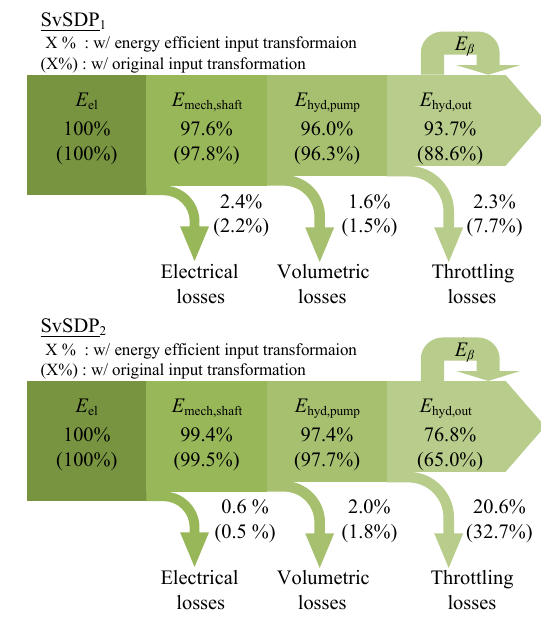
Figure 18: Sankey diagram showing the energy distri- bution from electrical input to hydraulic output for the SvSDP drives. In parenthe- sis are the results using the original input